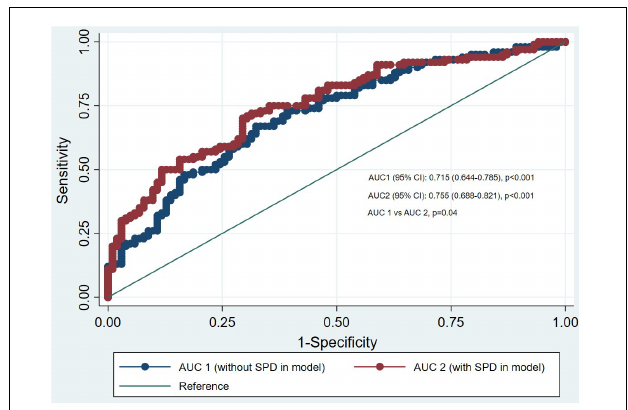
FIGURE 3 | Receiving operating characteristics curves for incident stroke from multivariable conditional logistic regression models with and without spermidine of nested case-control